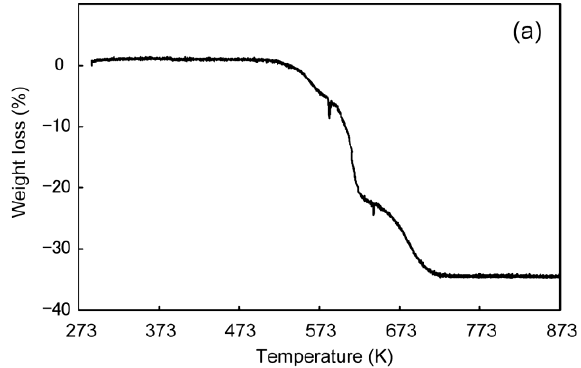
Figure 5. ( a ) TG curve of recrystallized C C py-W before and after the impedance spectroscopy measurements at 423 16 10